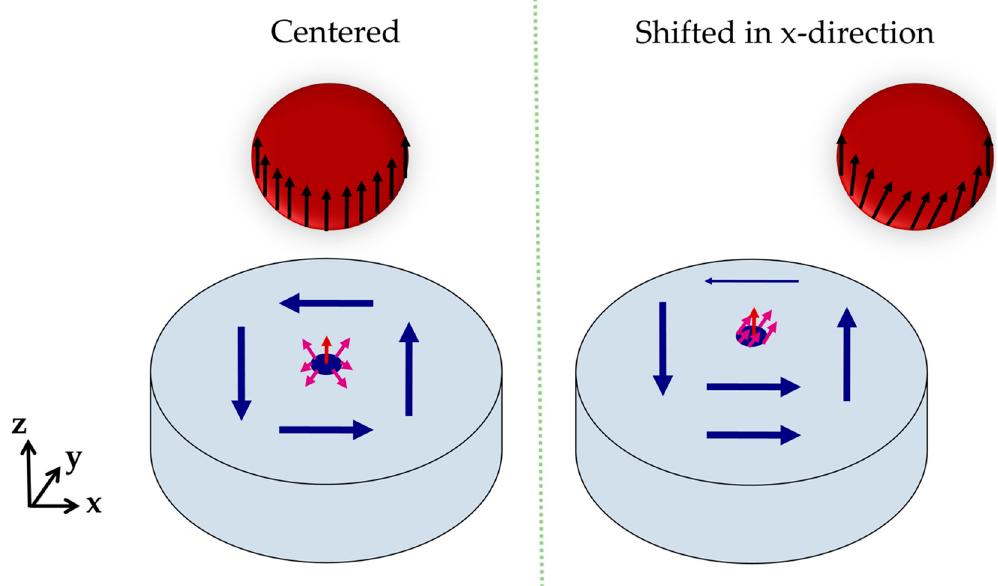
Figure 6. Schematic view on the vortex movement within the free layer by shifting the label in the x-direction. The labels shift urges the spins surrounding the vortex core to align more in the x-direction.